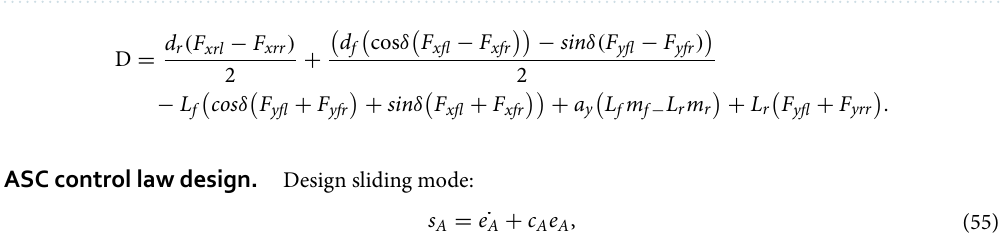
Figure 3. Architecture of multidirectional motion coupling control